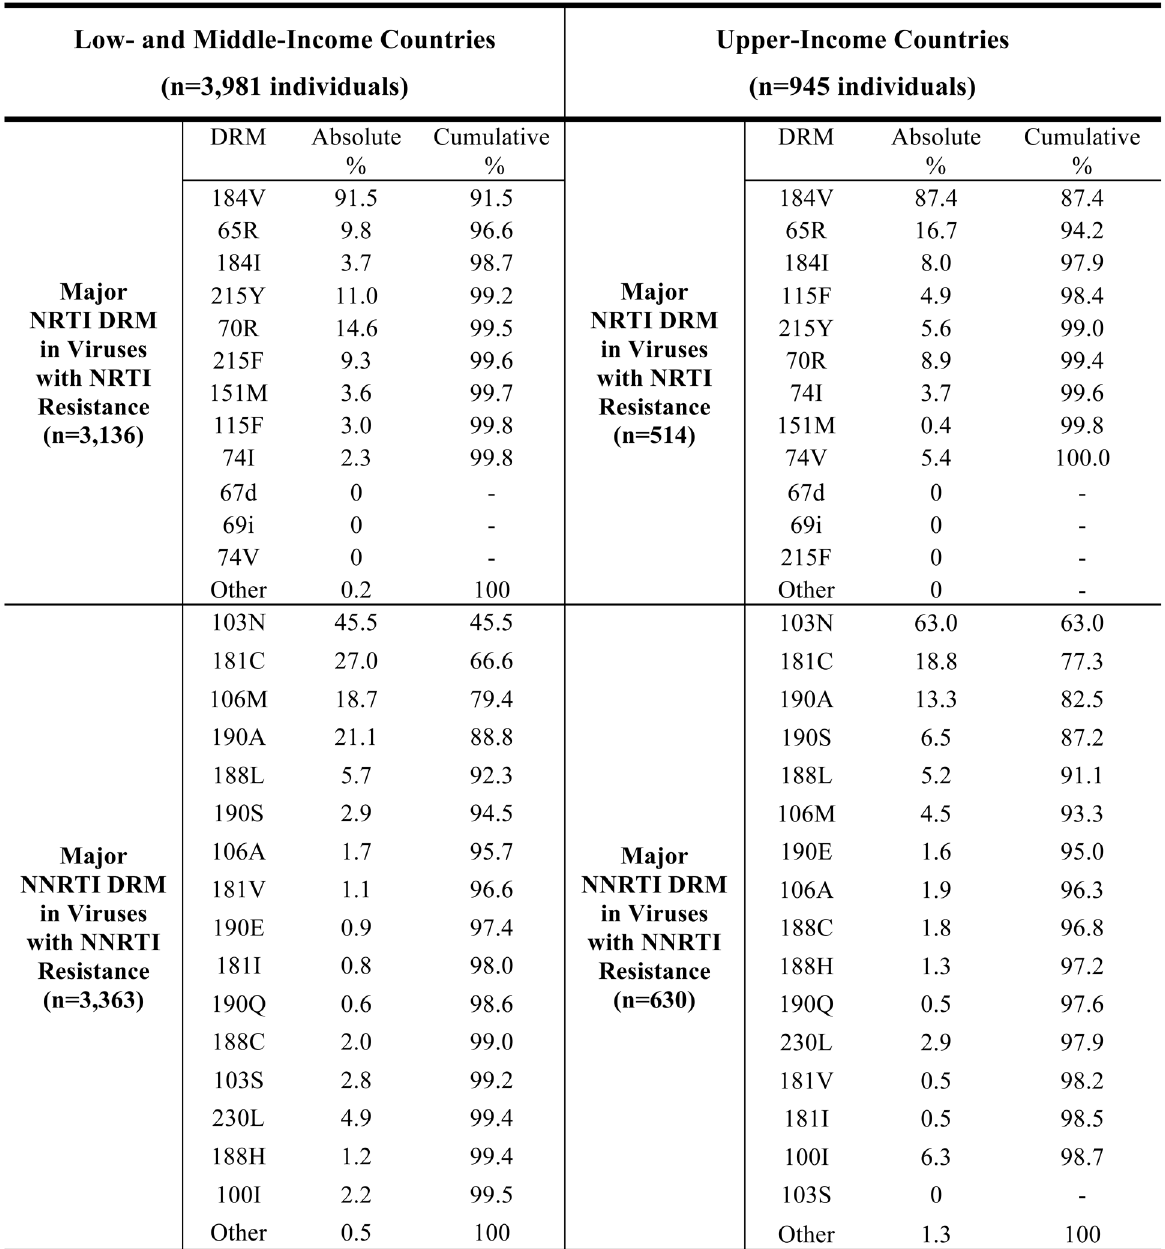
Fig 2. Prevalence of major NRTI and NNRTI resistance mutations in individuals with acquired drug resistance. Absolute and cumulative prevalence of each major nucleoside (NRTI) and nonnucleoside RT inhibitor (NNRTI) drug-resistance mutation (DRM) in 4,926 individuals with virological failure and intermediate or high-level acquired NRTI or NNRTI resistance while receiving a first-line NRTI/NNRTI-containing regimen are shown. Regimens include four AZT/d4T-containing regimens — AZT/d4T+3TC+EFV/NVP (n = 4,020), four TDF-containing regimens — TDF+3TC/FTC+EFV/NVP (n = 772), and two ABC- containing regimens — ABC+3TC+NVP/EFV (n = 134). Low- and Middle-Income Countries: Countries of Sub-Saharan Africa, South / Southeast Asia, and Latin America and Caribbean; Upper-Income Countries: Countries of North America and Europe, and upper-income countries in Southeast Asia. NRTI DRM with an HIVDB score (cid:1) 30. There were no insertions or deletions between codons 67 and 70. NNRTI DRMs with an HIVDB score (cid:1) 60. Absolute %: number of individuals with DRM / number of individuals with intermediate or high-level NRTI or NNRTI resistance. Cumulative %: number of individuals with one or more of the preceding DRMs in the list / number of individuals with intermediate or high-level NRTI or NNRTI resistance.